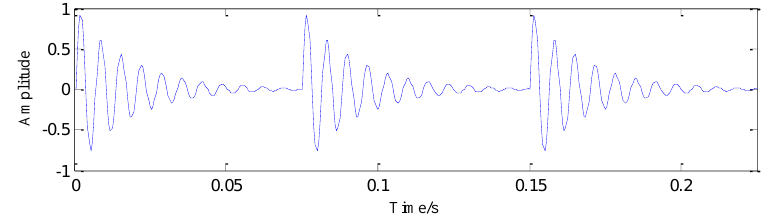
Figure 1. Waveforms of the simulated signal.